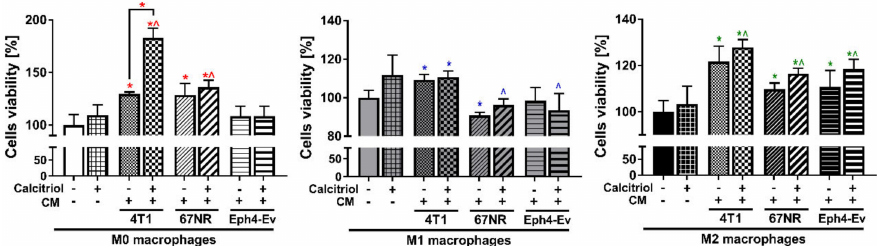
Figure 5. Proliferation of various BMDMs classes stimulated with conditioned media (CM), with or without calcitriol. 4T1 CM have the greatest impact on macrophage proliferation, regardless of the BMDMs class. All CM stimulate the proliferation of M2 BMDMs. The e ff ect of CM from 4T1, 67NR, and Eph4-Ev cultures with or without calcitriol on the proliferation of polarized BMDMs was estimated by the SRB (Sulforhodamine B) test. Briefly, 80% TCA acid was applied on the wells. After 1 h, the wells were rinsed 5 times with distilled water and 0.1% sulforhodamine B solution was added for 30-min incubation. After this time, the wells were rinsed 5 times with 1% acetic acid. The pellet was dissolved in a 10 mM TRIS solution and absorbance was measured. Absorbance results from BMDMs of individual classes (M0, M1, M2) treated with CM in combination with or without calcitriol were referred to individual BMDMs polarized without the addition of CM and calcitriol (control, 100%). Data presentation: mean with standard deviation. Number of independent repetitions = 3 (BMDM cultures generated from three mice). Statistical analysis: Sidak’s or Dunn’s multiple comparisons test. * (red) p < 0.05 as compared to M0 or * (blue) p < 0.05 to M1 or * (green) p < 0.05 to M2 not treated with cal and any CM, ˆ (red) p < 0.05 as compared to M0 + cal or ˆ (blue) p < 0.05 to M1 + cal or ˆ (green) p < 0.05 to M2 + cal not treated with any CM; or as